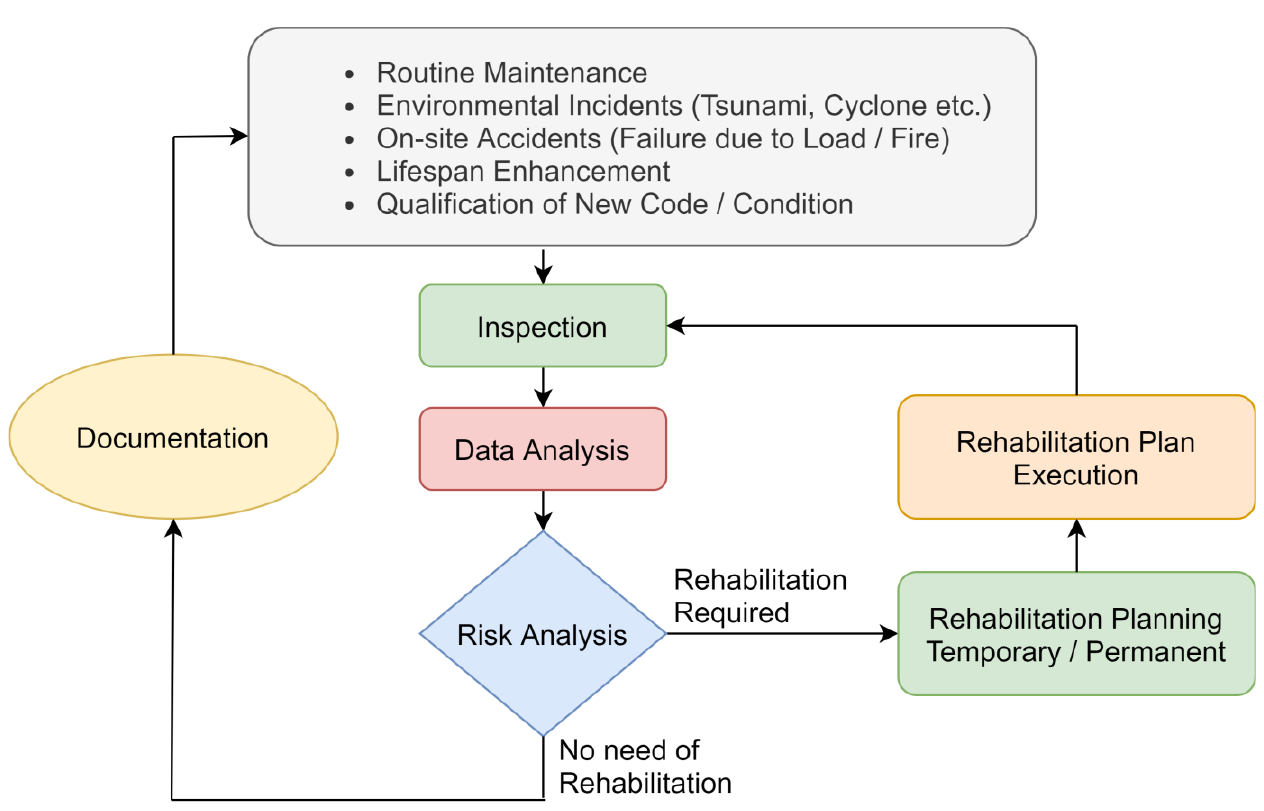
Figure 4. The typical process of rehabilitation requirement